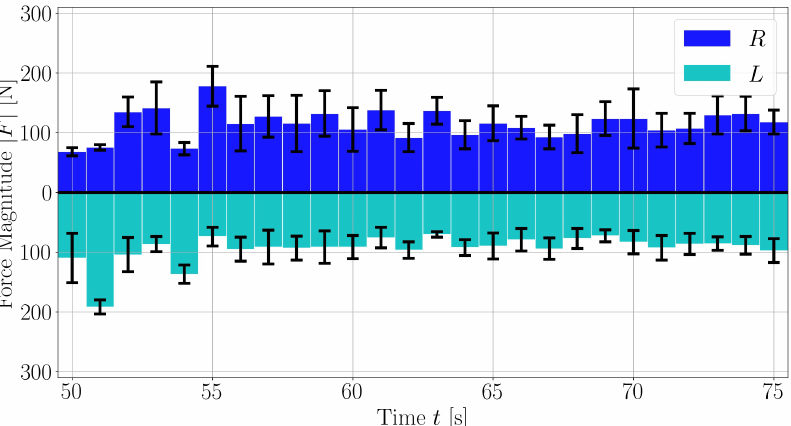
Figure 10. Average magnitude of the force exerted on pedal over time. Here, a section of a large assessment is shown. The averages are computed over 1s bins. The bars’ heights are the average force magnitude over the bin, and the error bars span plus and minus one standard deviation.